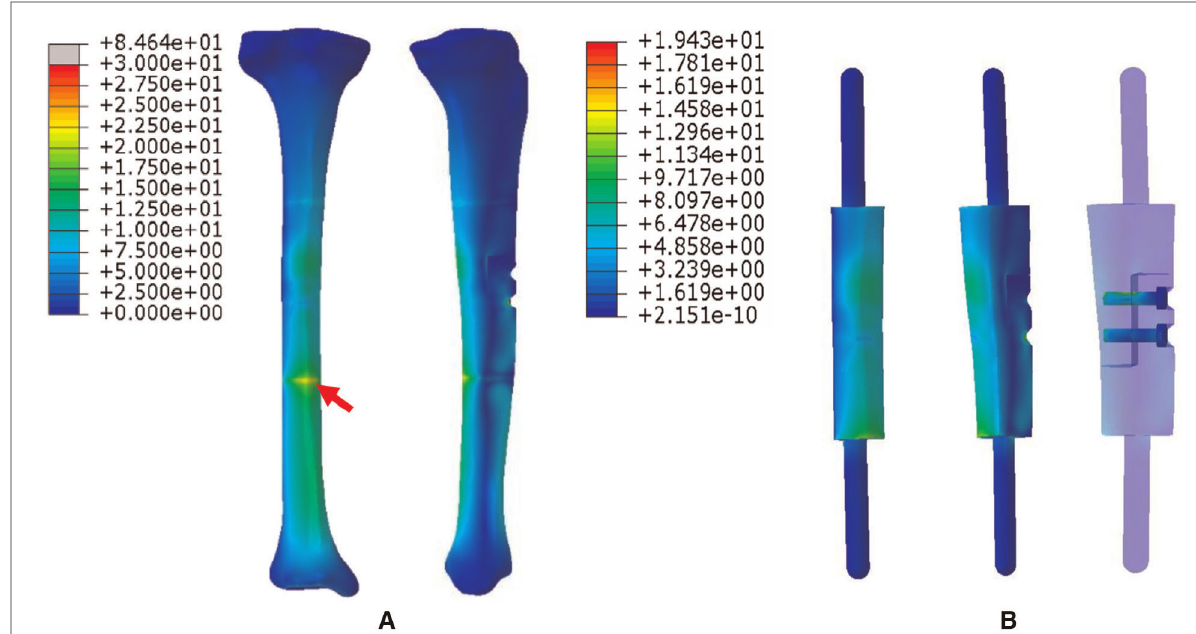
FIGURE 7 Von Mises stress distribution in Mode III, the red arrows indicate the maximum stress concentration. ( A ) Stress distribution of the integral structure. ( B ) Stress distribution of the prosthesis and internal fi xation.